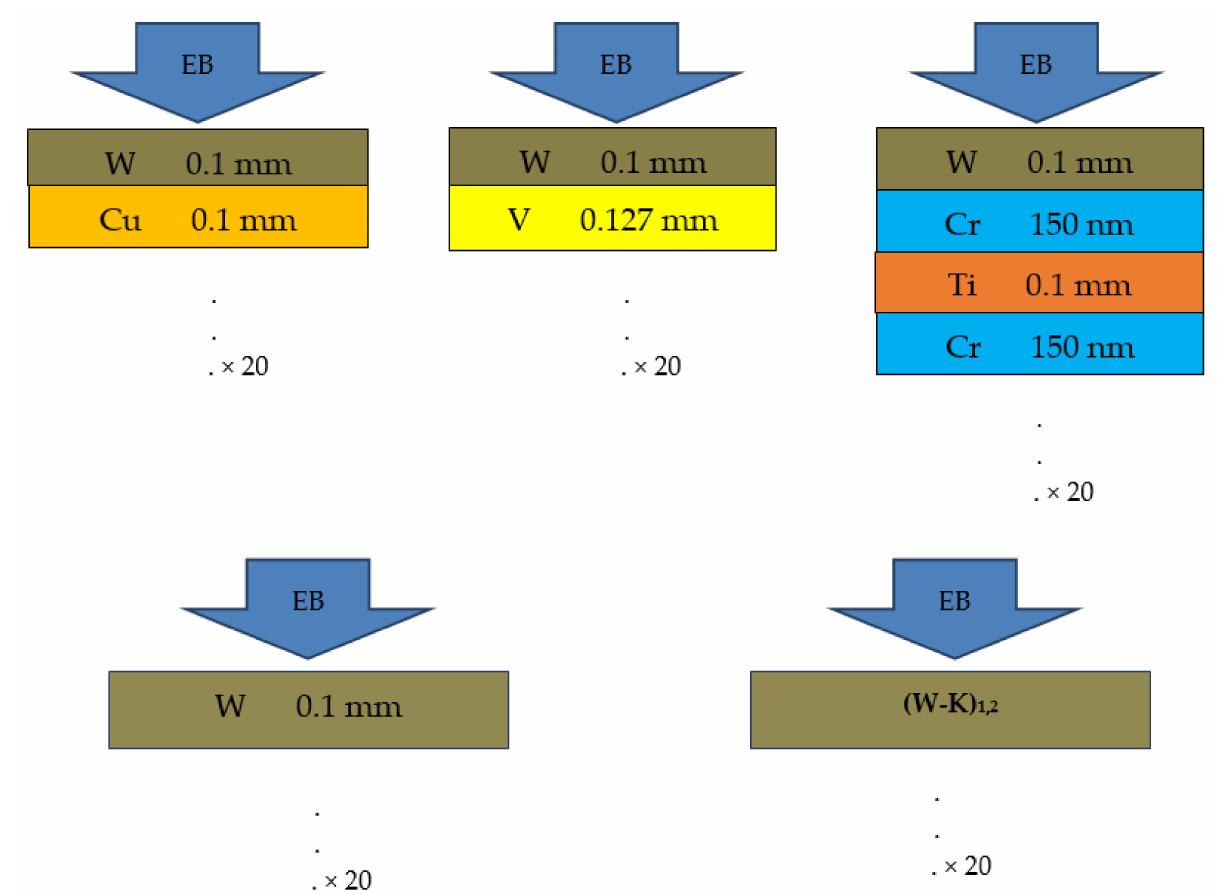
Figure 1. Sketch of the structure of the W-Cu, W-V, W-Ti, and pure W and K-doped W laminates (not to scale). The laminates consist of alternating foils W/Cu/W/Cu . . . , W/V/WV . . . , W + Cr/Ti/Cr + W + Cr/Ti . . . with a total of 40 foils. The K-doped W laminates were produced from 100 and 220 µ m foils, for (W-K) 1,2 , respectively. The samples are irradiated with the EB perpendicular on the top W